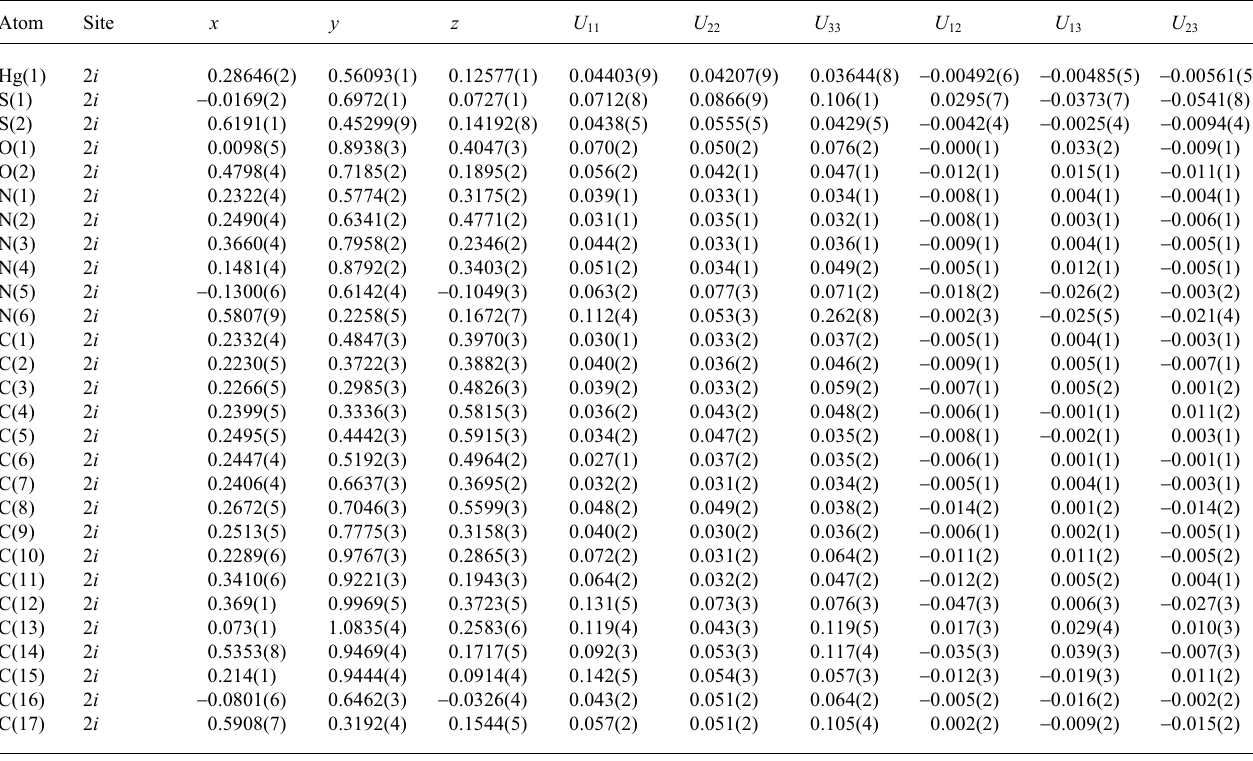
Table 3. Atomic coordinates and displacement parameters (in Å 2 ).